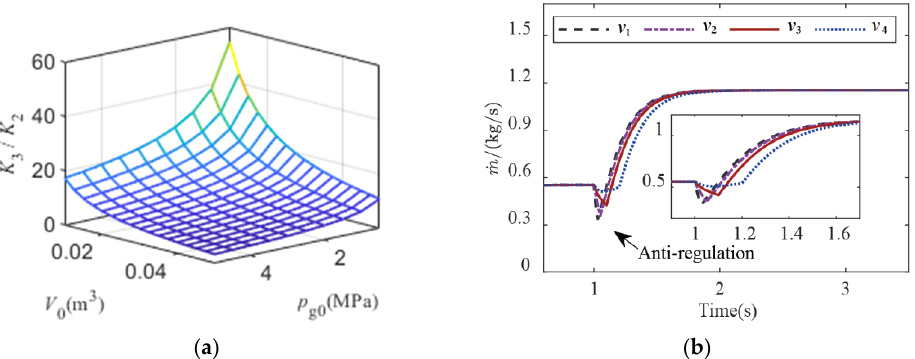
Figure 5. Anti-regulation characteristics analysis ( a ) Value of K 3 / K 2 ; ( b ) Simulation of the anti-regulation of the gas flow.